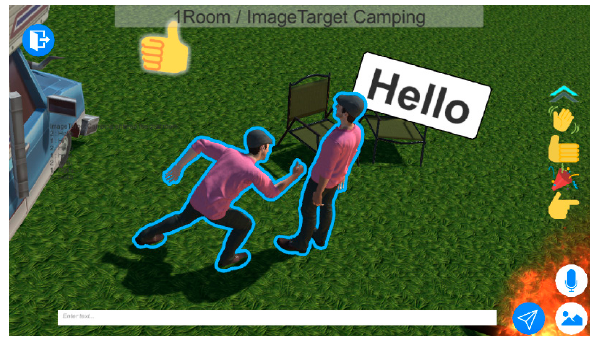
Figure 8. Adjustment of display result considering camera position.